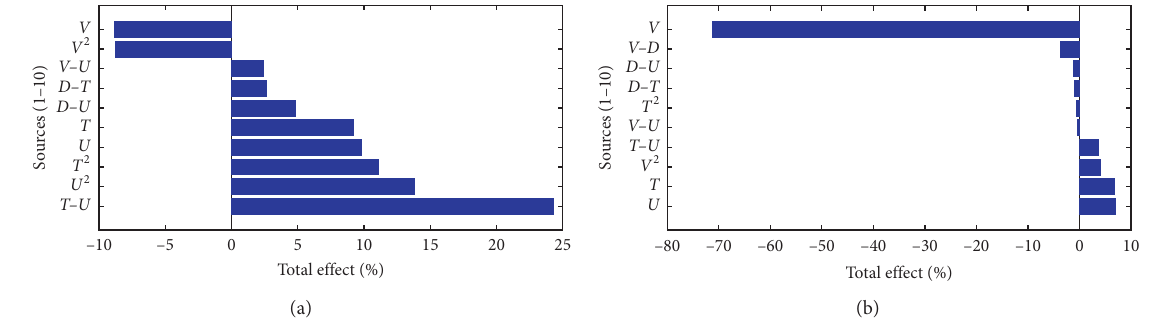
Figure 16: Pareto plots of HPS: (a) damping and (b) stiffness characteristics.